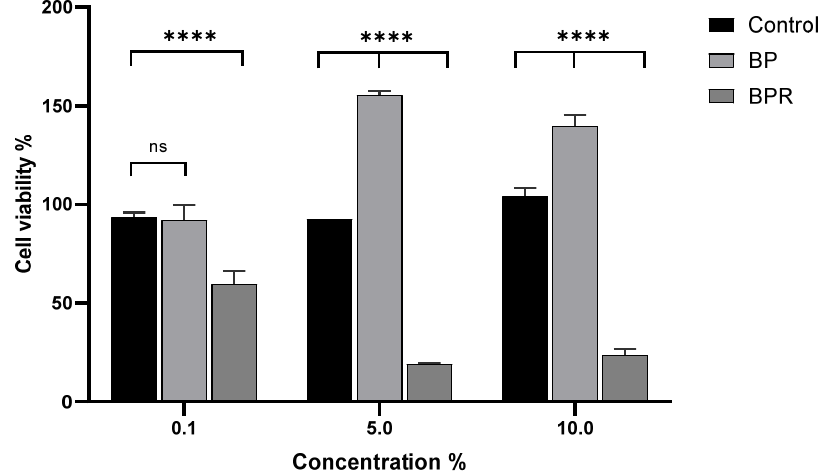
Figure 1. HCT-8 cell viability based on MTT protocol in the case of banana peel extracts. Different numbers of asterisks represent significant statistical differences (**** p < 0.001; ns—not significant), n = 3.